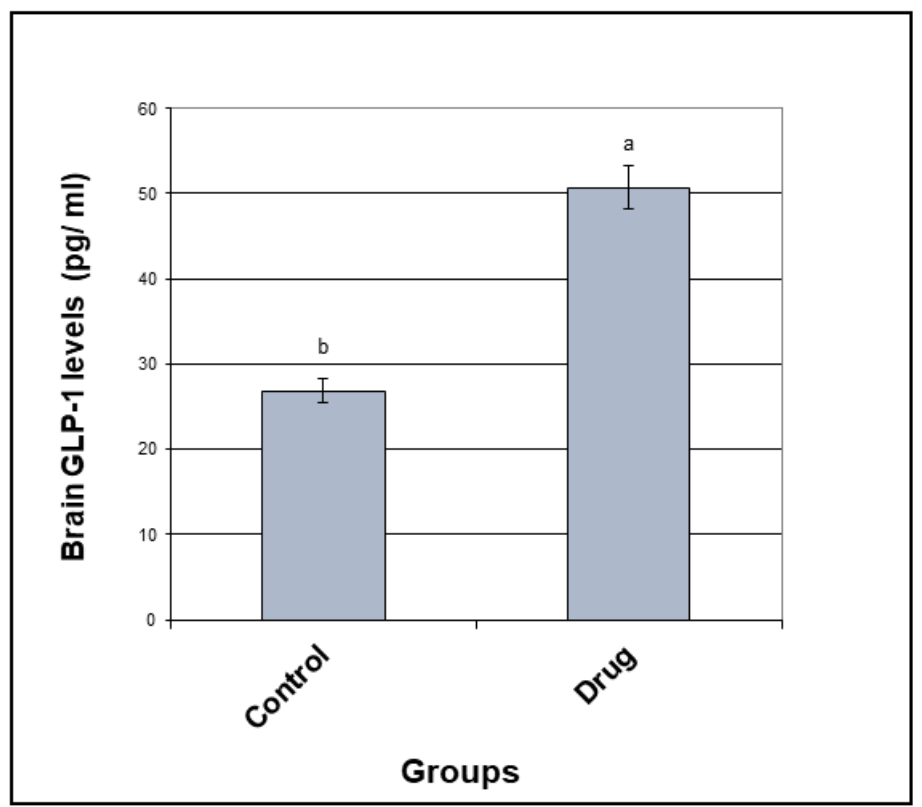
Figure 4. Statistical analysis of GLP-1 concentration in the drug group against the control group.